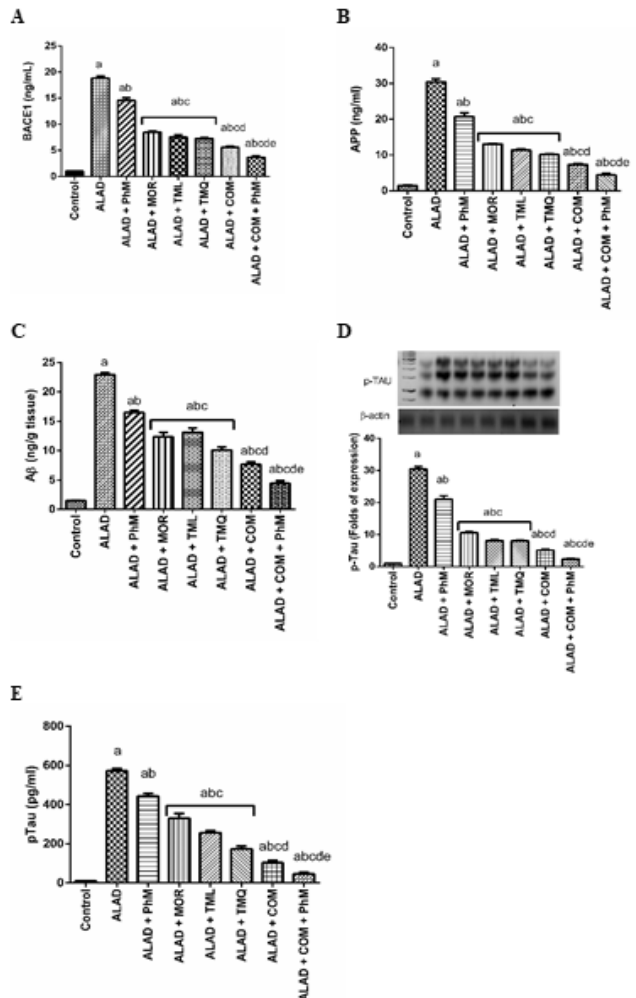
Figure 6. The effect of phytochemicals combination, MOR, TML, and TMQ, with PhM on Aβ aggre- gation and Tau hyperphosphorylation in AD. ( A ) BACE1 levels, ( B ) APP levels, ( C ) Aβ levels, ( D ) Folds of p-Tau protein expression, ( E ) p-Tau levels. The data are presented as means ± SD ( n = 7). Significance (a): relative to the control group. Significance (b): relative to the ALAD group. Signifi- cance (c): relative to ALAD + PhM group. Significance (d): relative to either ALAD + MOR, ALAD + TML, or ALAD + TMQ group. Significance (e): relative to ALAD + COM group Significance: p < 0.05. The data of the effect of MOR, TML and TMQ on the control are not shown as they were not signif- icant.